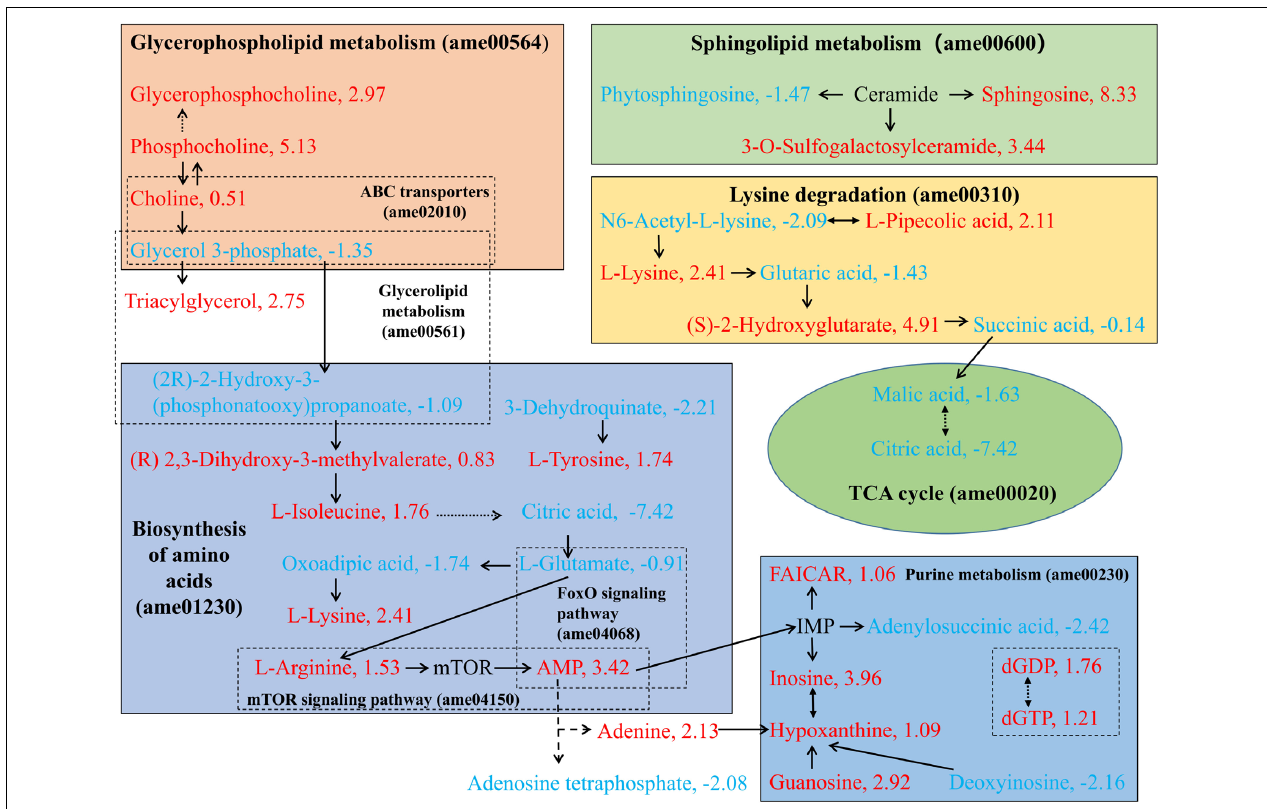
FIGURE 8 | Summary of the primary metabolic pathways that changed in the comparison of NLQS with VQS in the honeybee Apis mellifera . The pathways were summarized and outlined based on the KEGG database (see footnote). The profiles of differentially expressed metabolites were obtained from the LC–MS of metabolomic data. The text color indicates the level of change in the NLQS compared with that in the VQS: a red, positive number indicates a higher level; a blue, negative number indicates a lower level. Solid arrows indicate direct action; dashed arrows indicate a remote-action relationship; and double-sided arrows indicate